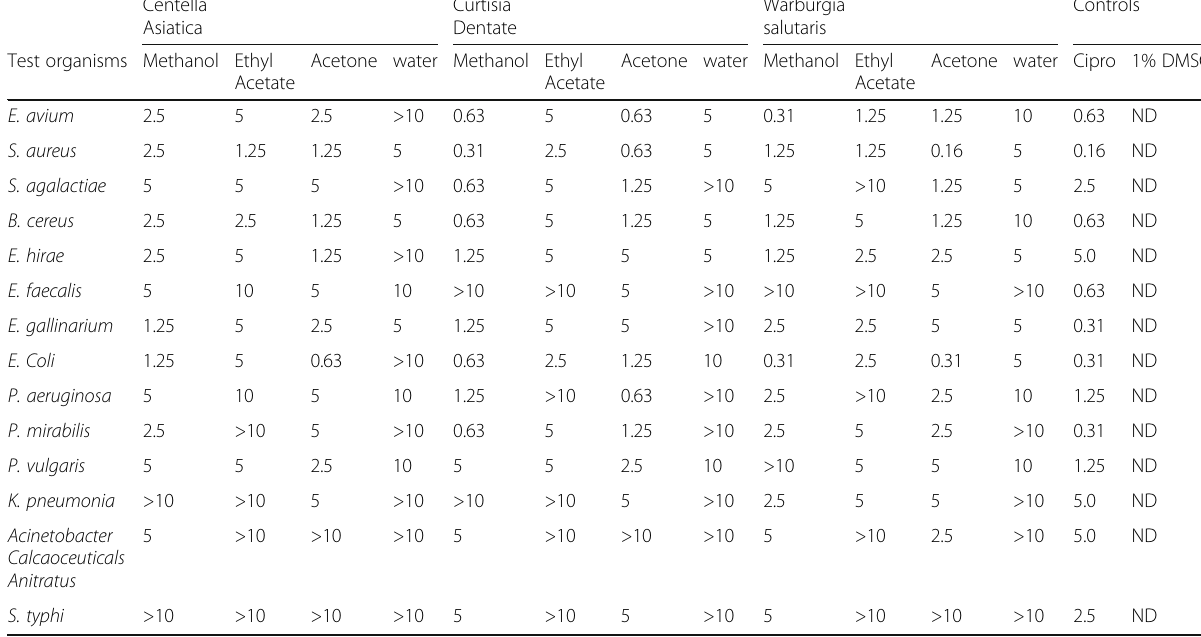
Table 2 The MIC (mg/ml) values of Centella asiatica , Curtisia dentate and Warbugia salutaris extracts against bacteria Centella Curtisia Asiatica